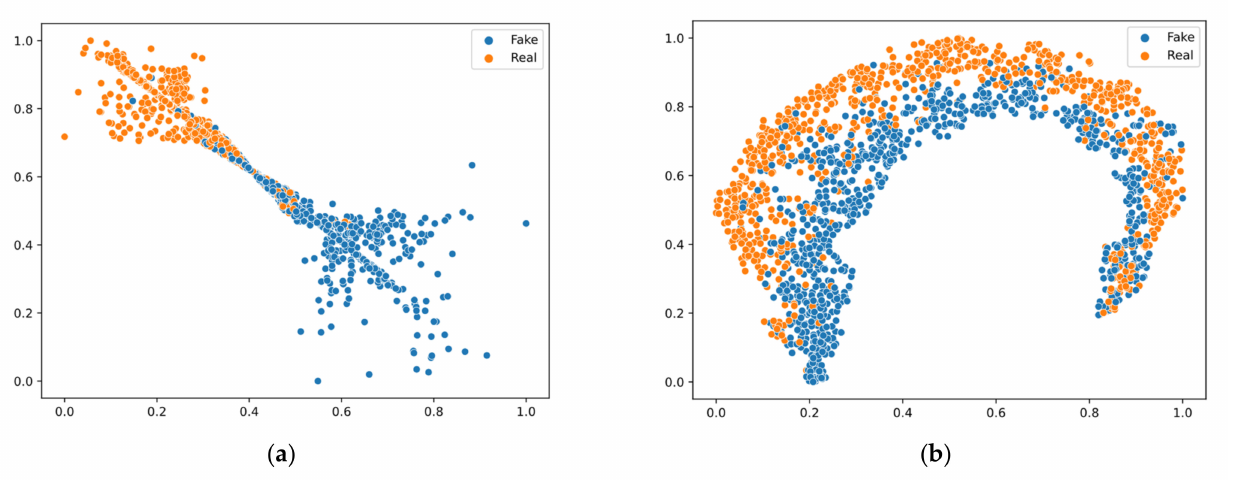
Figure 3. Visualization of the joint representation: ( a ) FMFN; ( b ) FMFN